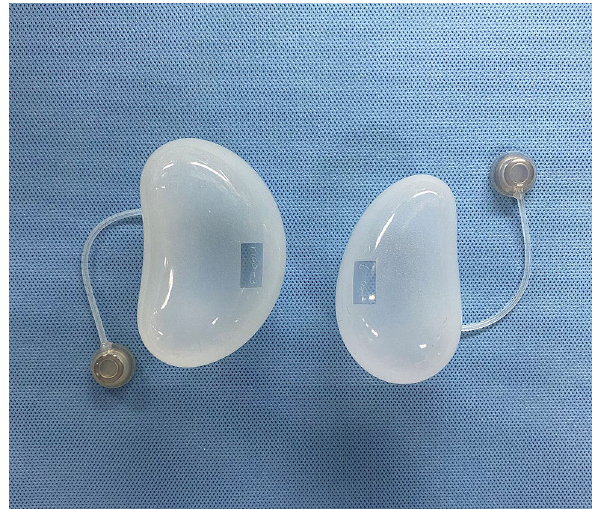
Figure 7. The specifications of the two tissue expanders that are most commonly used in auricular reconstruction. Left 100 ml, right 50 ml.